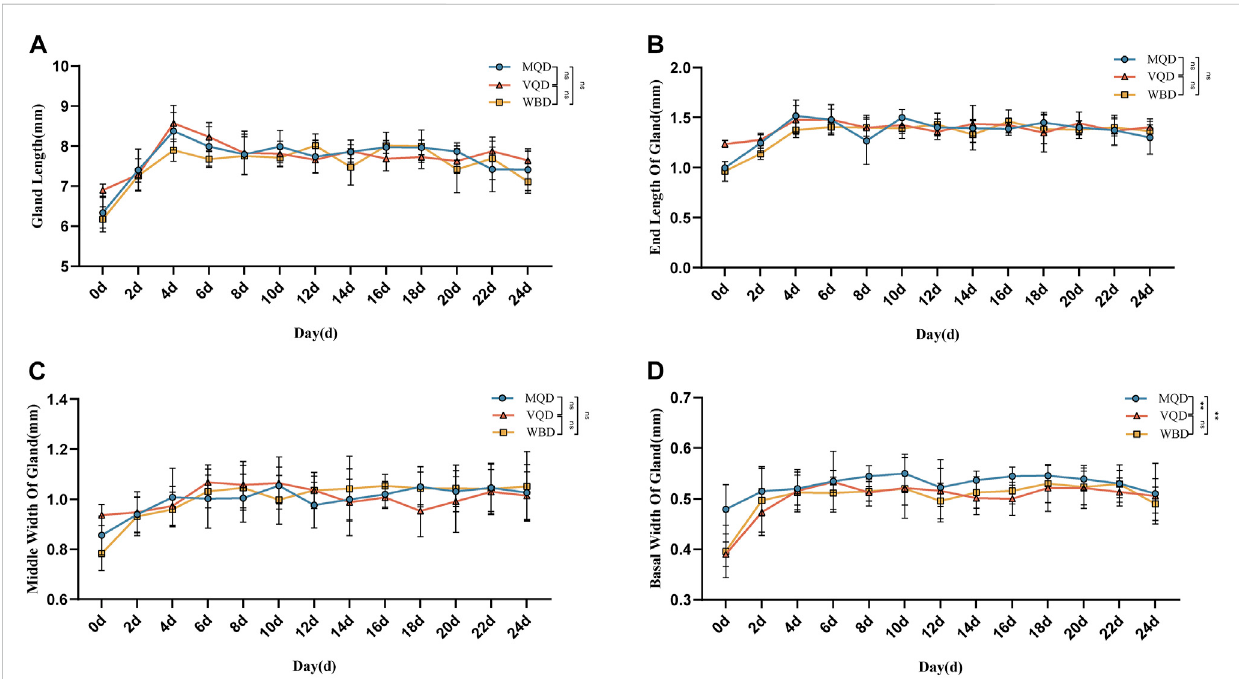
FIGURE 2 Age-related development processes of mucous glands in drones: (A) length of the mucous gland; (B) end width of the mucous gland; (C) middle width of the mucous gland; (D) basal width of mucous gland MQD: drones from mated queens; VQD: drones from virgin queens; WBD: drones from worker